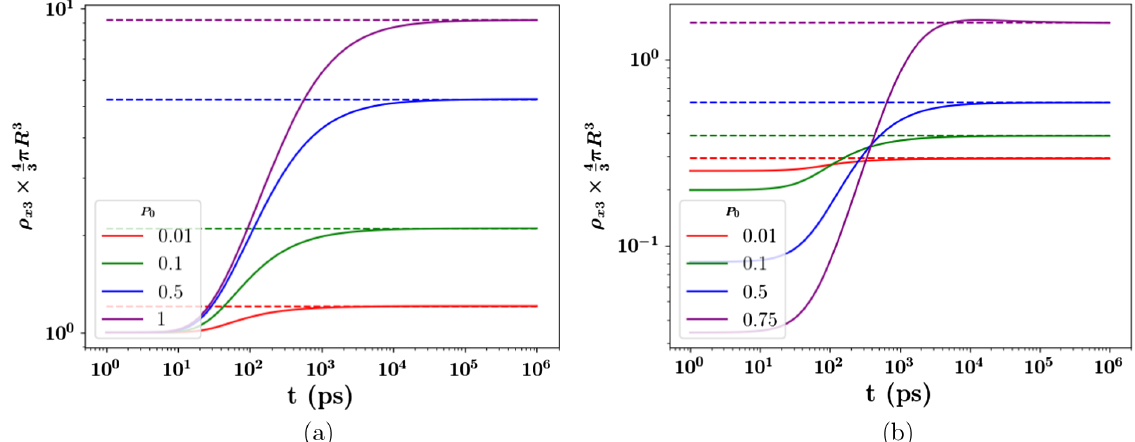
FIG. 8. The time evolution (solid lines) of ρ , defined in the text, for a distribution with 1 . 602 mC in (a) an initially uniform sphere of x 3 width 1 mm and (b) an initially Gaussian sphere with standard deviation of 1 mm. The dashed lines indicate the corresponding highly- relativistic limit of ρ obtained analytically. Again, the formation of the density peak from these relativistic considerations is apparent in x 3 the graphs. Similar to how the planar symmetric density freezes, ρ can be seen to asymptote; however, this is due to the Lagrangian x 3 particle reaching their terminal velocity, the difference of which is relativistically contracted, as described in the text.